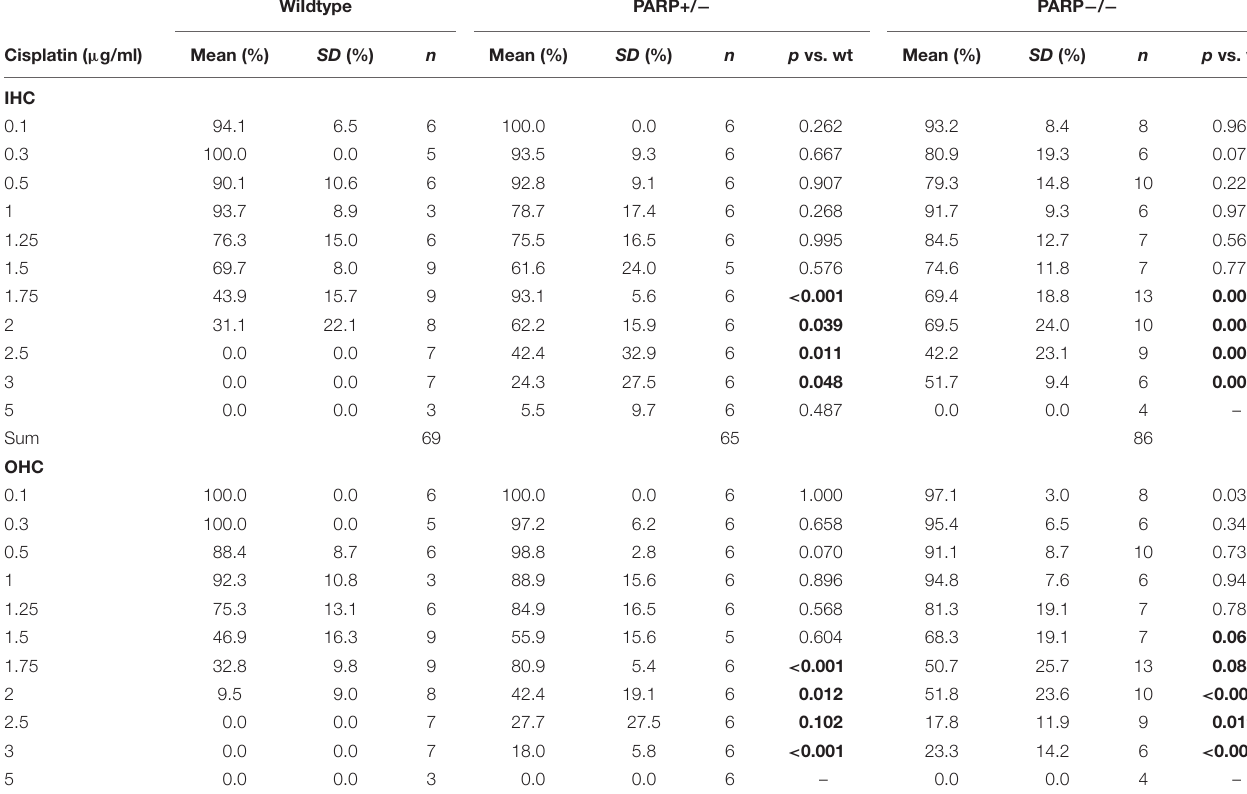
TABLE 1 | Mean cochlear perservation (arithmetic mean, fraction) at different cisplatin concentrations in the different genotypes. WiIdtype PARP+/ −